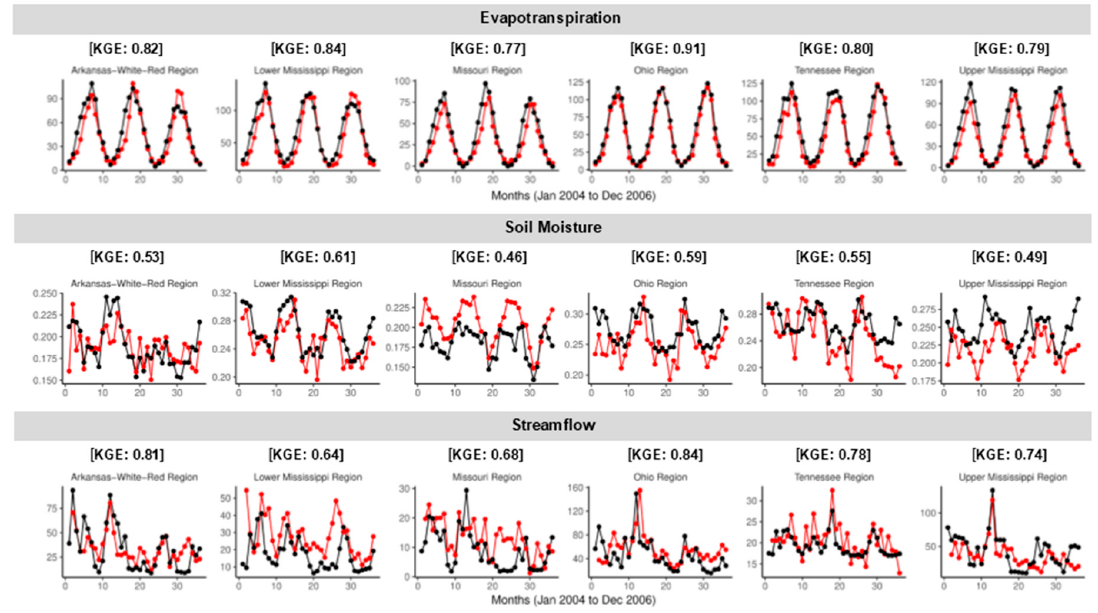
Figure 2. Time series plots of (1) top panel: Evapotranspiraton-calibrated (ET-calibrated) model ET (red) and the Global Land Evaporation Amsterdam Model (GLEAM) observed ET (black) in mm / month, (2) middle panel: Soil moisture-calibrated (SM-calibrated) model SM (red) and the European Space Agency–Climate Change Institute (ESA–CCI) observed SM (black) in m 3 / m 3 and (3) bottom panel: Streamflow-calibrated (SF-calibrated) model SF (red) and observed Hydrologic Unit Code-2 (HUC-2) runo ff (black) in mm / month for the six HUC-2 sub-catchments of the Mississippi basin. The first 12 months correspond to the calibration period of 2004 and the next 24 months correspond to validation years 2005 and 2006. The corresponding Kling-Gupta E ffi ciency (KGE) values are presented in each panel.